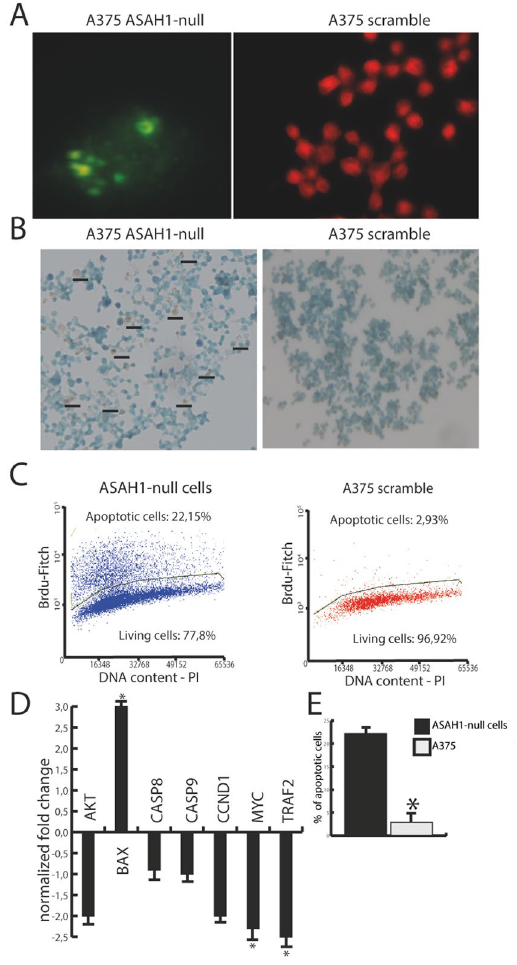
Figure 5. AC deletion causes apoptosis. ( A ) ApoBRDU nuclear staining in ASAH1 -null (left) and control (scramble-treated) cells (right). ( B ) Immunostaining show the presence of apoptotic bodies in A375 ASAH1 - null but not in control (scramble-treated). ( C ) Flow cytometry analysis after ApoBRDU staining shows increased apoptotic events in ASAH1 -null cells after 10 days in culture. ( D ) Real-Time PCR quantification of gene transcripts related to apoptosis in ASAH1 -null and control cells. Results are expressed as mean ± SEM, n = 3, with each experiment performed in technical and biological triplicates: experiments were performed using three replicates each and repeated three times. * p < 0.05, ** p < 0,01, *** p < 0.001, Student’s t test. ( E ) Statistical analysis of positive marked nuclei after ApoBRDU staining, results are expressed as mean ± SEM, n = 3, with each experiment performed in technical and biological triplicates: experiments were performed using three replicates each and repeated three times. * p < 0.05, ** p < 0,01, *** p < 0.001, Student’s t test. Experiments were performed 17 days after CRISPR/Cas9